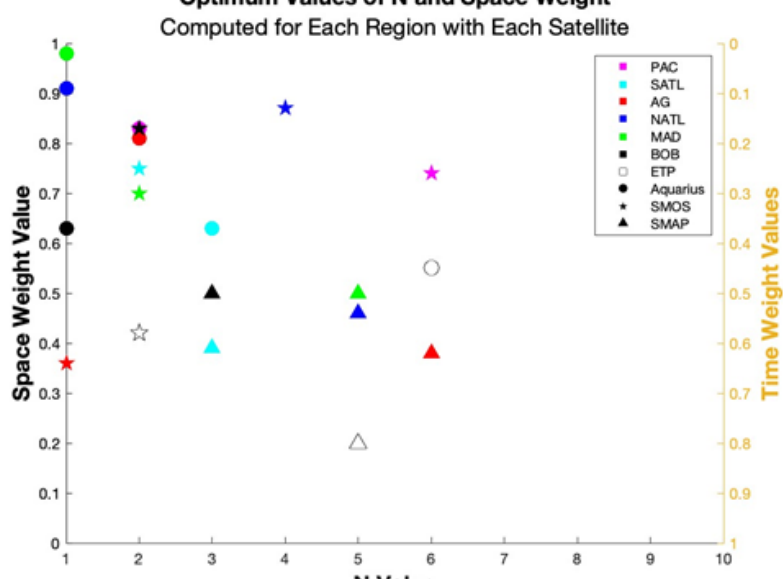
Figure 5. A summary of the optimum N and space_weight values determined for each region when optimized for the Aquarius, SMOS, and SMAP satellites. As noted in the legend, the different satellites are denoted by the star, circle and triangle symbols, and the different regions are denoted by different colors. This data can be found tabulated in the Supplementary Information (Table S1).